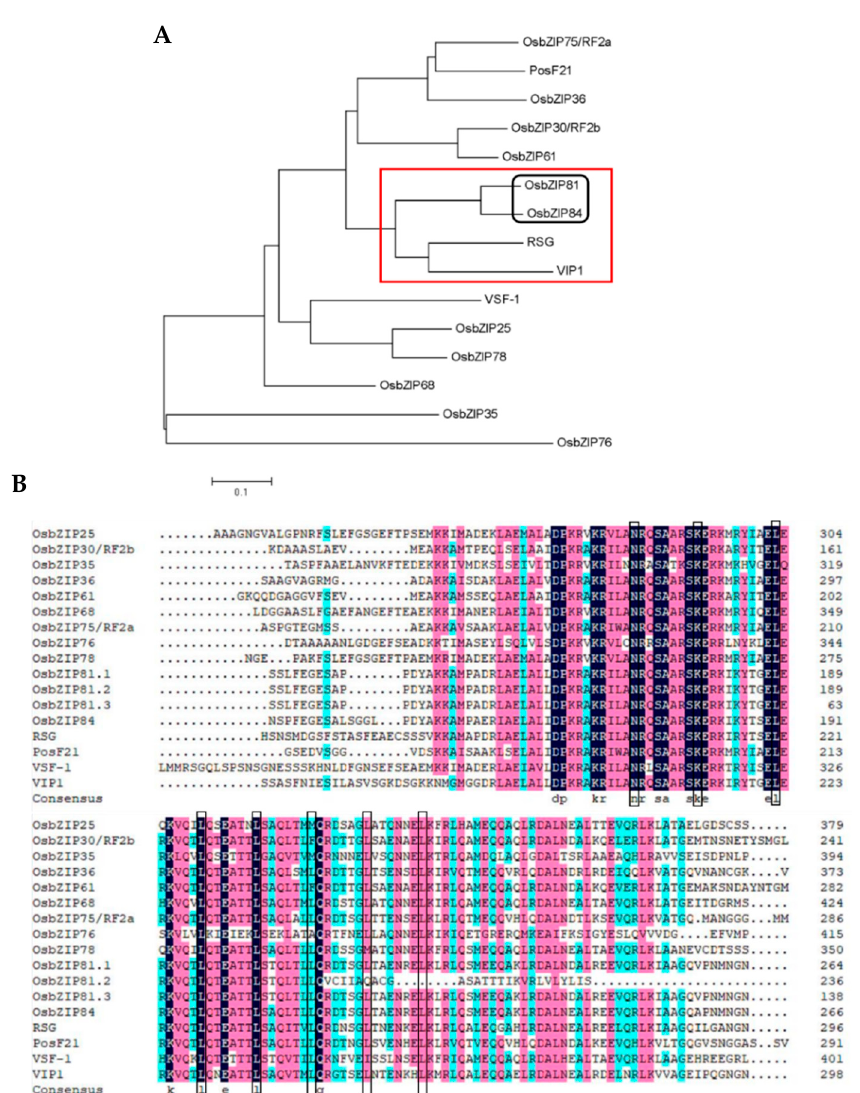
Figure 1. Evolutionary relationship of OsbZIP81 homologs and alignment of basic region/leucine zipper motif (bZIP) domains. ( A ) The evolutionary relationship of OsbZIP81 and its homologs, including the same subfamily members from rice, VIP1 and PosF21 from Arabidopsis, RSG from tobacco and VSF-1 from tomato. The evolutionary history was inferred using the maximum likelihood method. The software ClustalX (v. 1.83) and MEGA7 were used. The closest evolutionary relationship of OsbZIP81 were circled with different colored boxes (black box and red box). ( B ) Alignment of the bZIP domain of OsbZIP81 homologues.